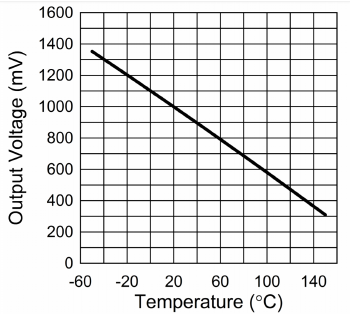
Figure 5. Output characteristic curve of